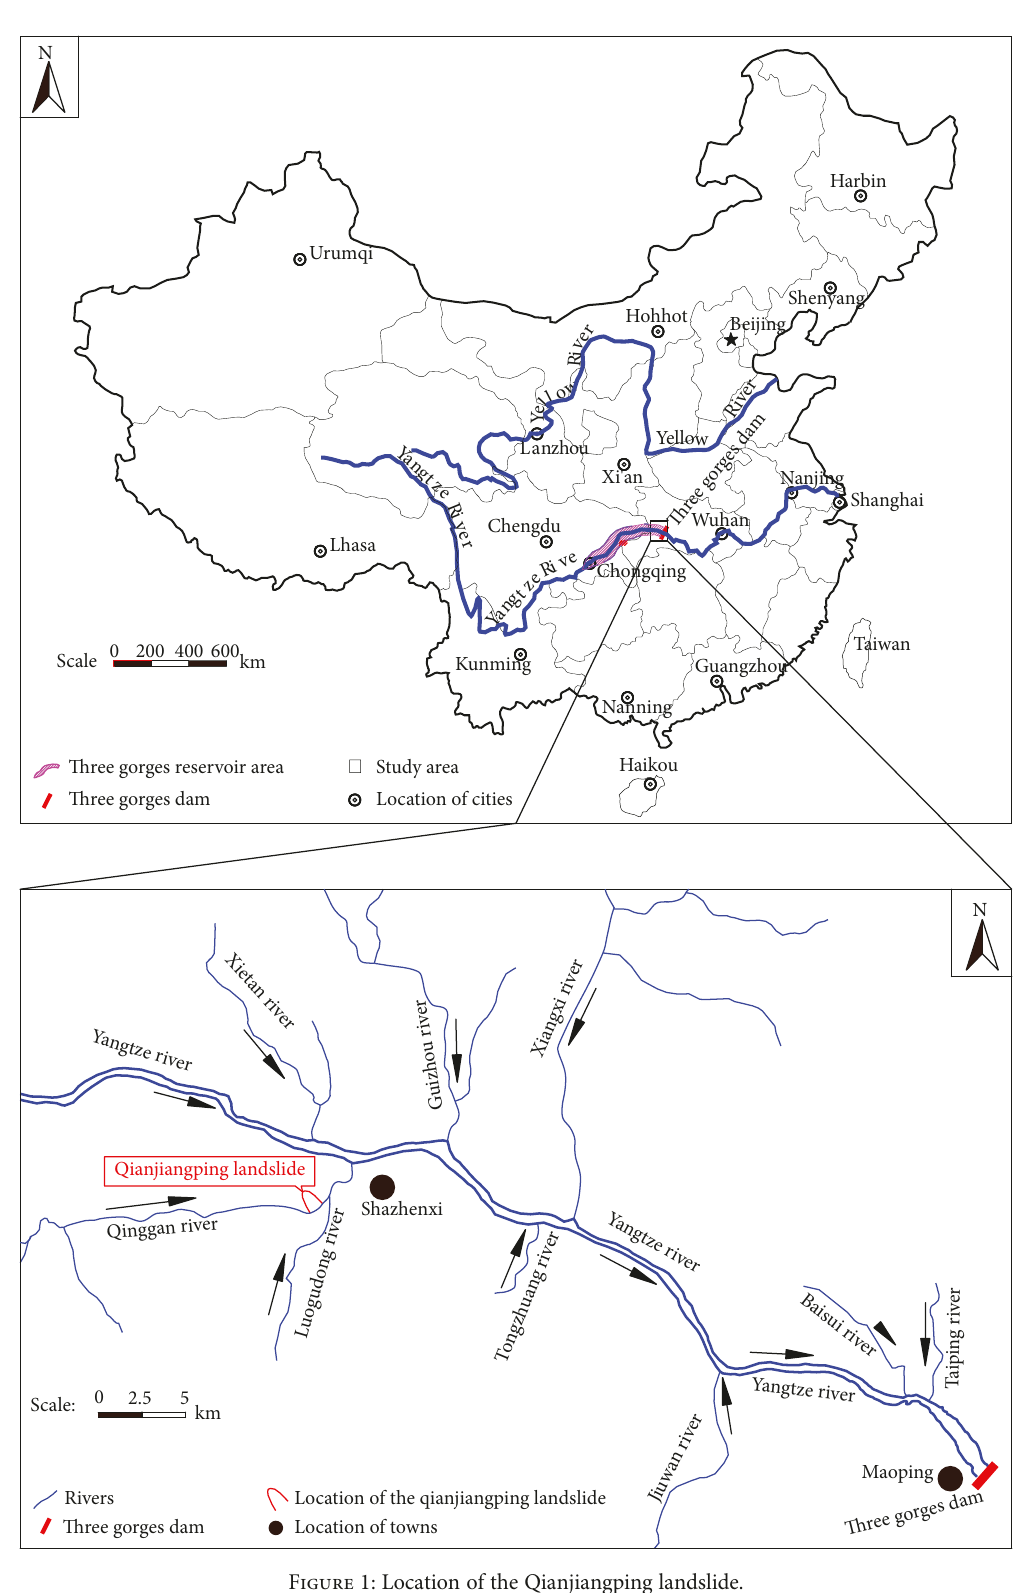
Figure 1: Location of the Qianjiangping